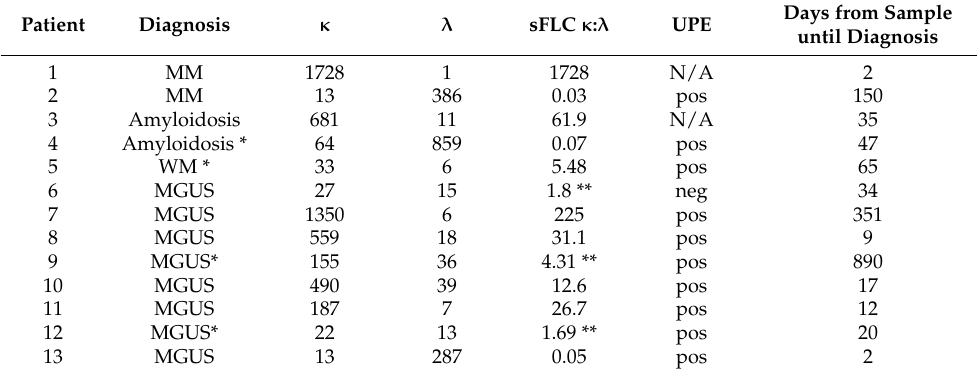
Table 3. Patients not identified by